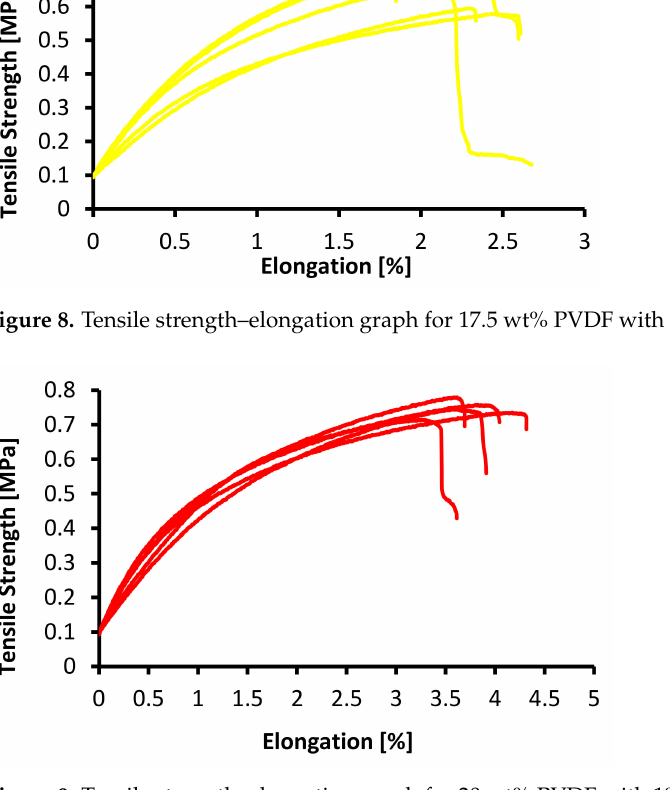
Figure 9. Tensile strength–elongation graph for 20 wt% PVDF with 1% tin